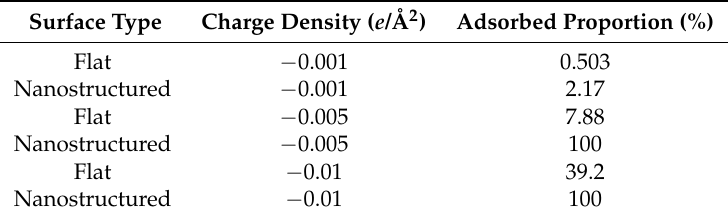
Table 1. The proportions of the fibrinogen main body that are adsorbed in simulations with flat and nanostructured